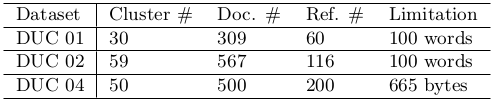
Table from the paper: Improving Multi-Document Summarization via Text Classification
Table text:
Dataset
Cluster#
Doc.#
Ref.#
Limitation
DUC01
30
309
60
100words
DUC02
59
567
116
100words
DUC04
50
500
200
665bytes